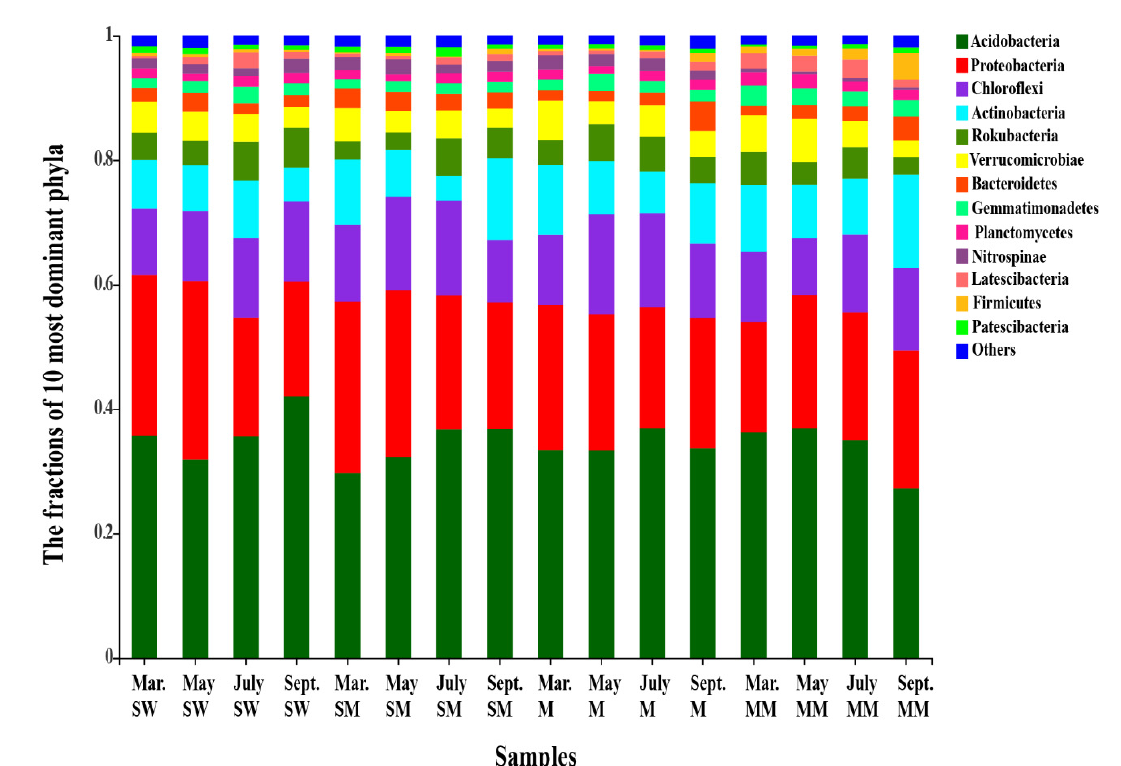
Figure 1. The fractions of the 10 most dominant phyla from different samples. The colors of the bars represent the bacterial phyla, and the length represents the relative abundance of the bacterial phyla in the corresponding sample. SW is swamp wetland, SM is swamp meadow, M is meadow, MM is mature meadow.